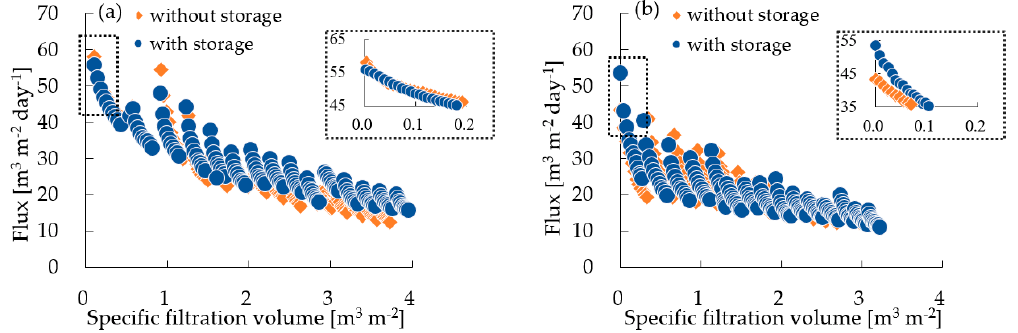
Figure 5. Profiles of normalized flux at 100 kPa during the filtration of November 2014 ( a ) and March 2015 ( b ) ( n = 2). The inset graphs show the magnified view of the dotted frame regions.